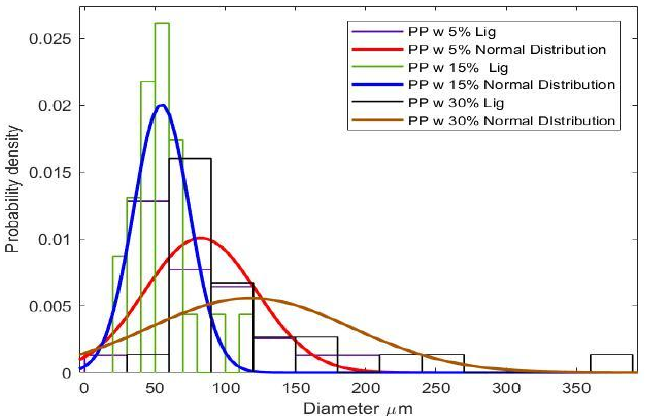
Figure 11. Probability density and histogram of tobacco lignin grain sizes.